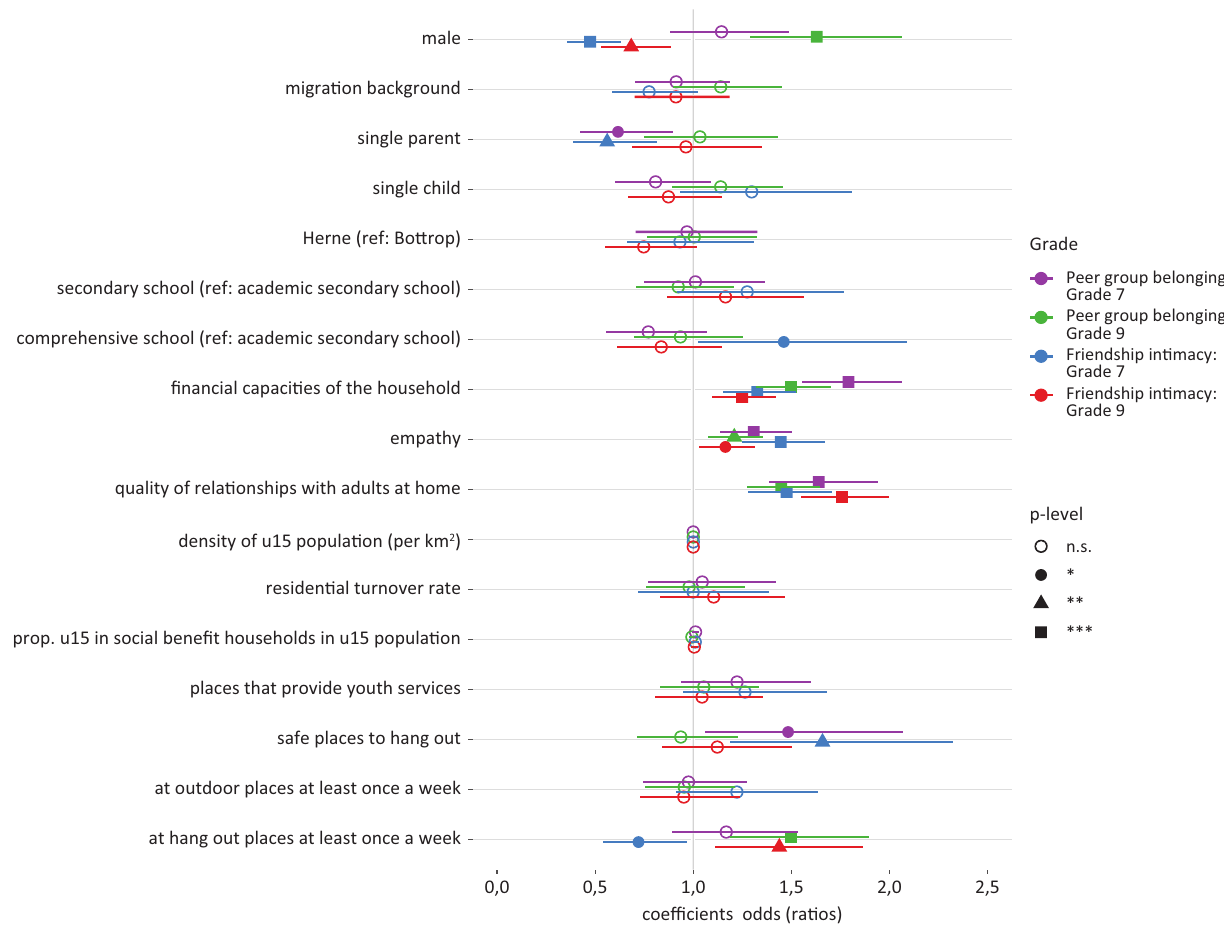
Figure 1. Effect sizes of final models. seems to be one of transition, where adolescents gain the autonomy that is necessary to form relationships with peers independently. Spatial independence and the appropriation of public spaces increase from early to middle